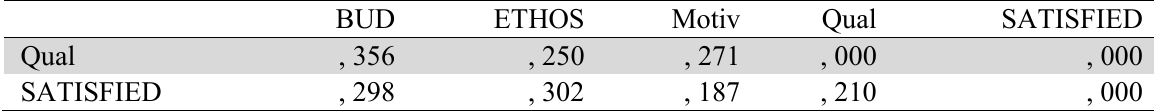
The results of regression analysis